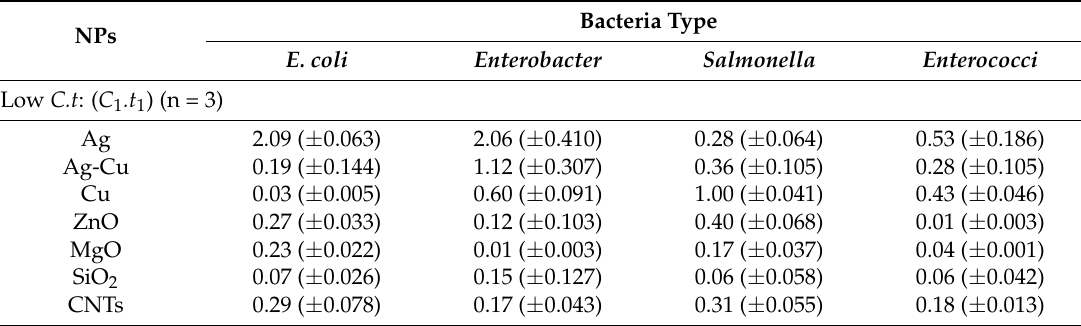
Table 8. Average log inactivation of spiked RO water treated by NPs a